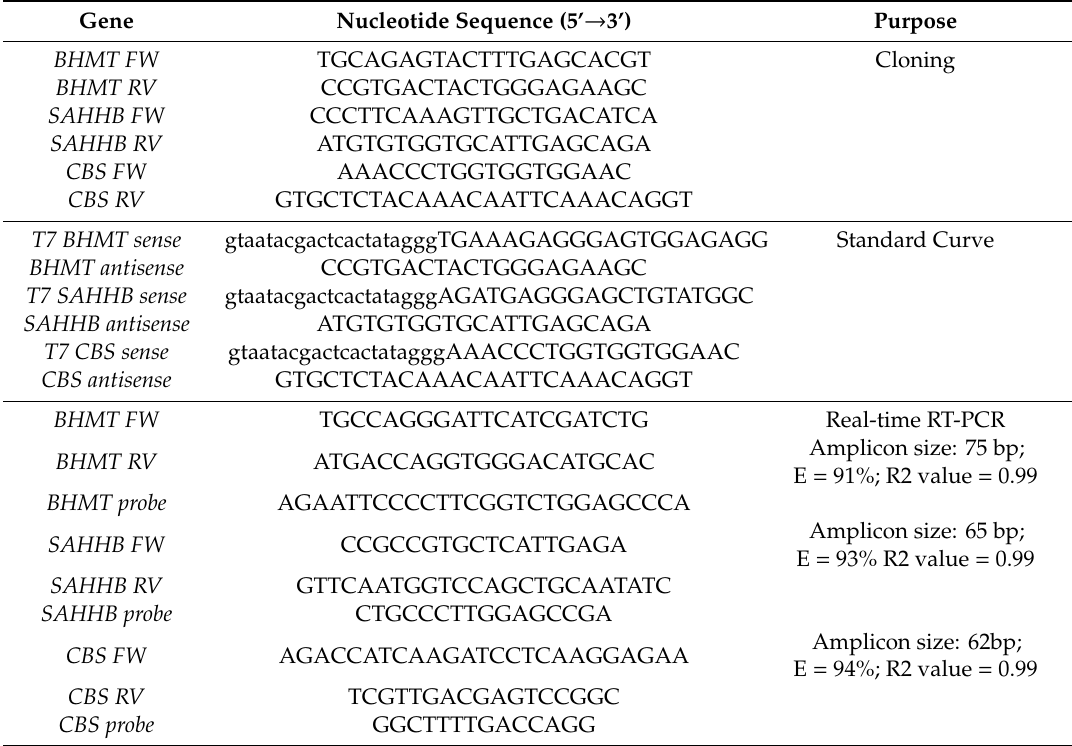
Table 1. Sequences of the primers used for molecular cloning and one-step quantitative real-time RT-PCR (reverse transcription polymerase chain